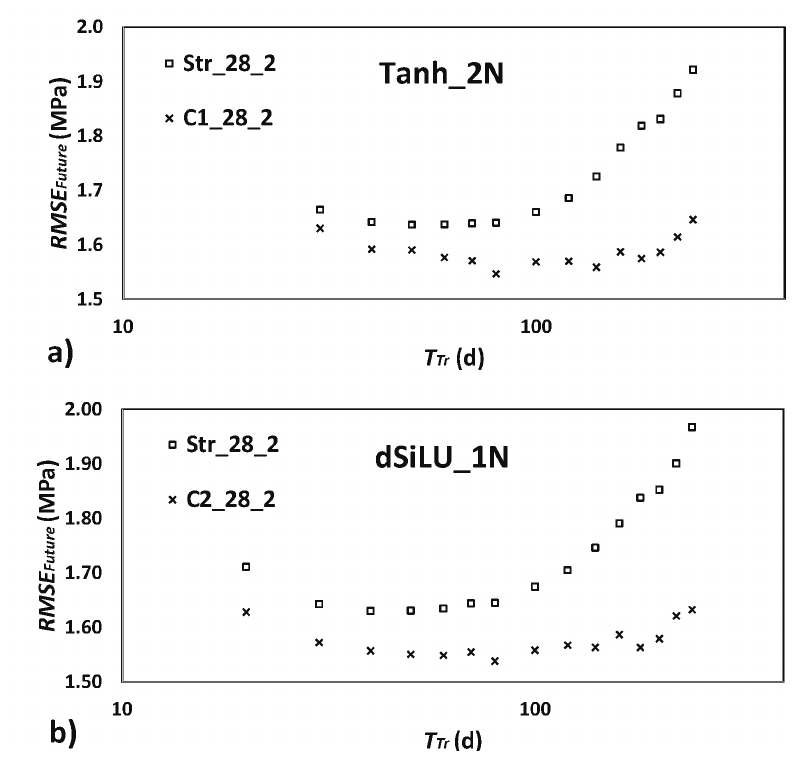
between the corrective models and Str_28_2 Future